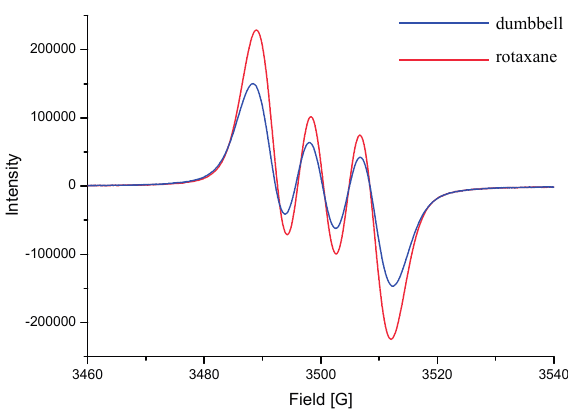
Figure 5. EPR spectra (CH 3 CN, 298 K) of equimolar (3 mM) mixtures of NOBF 4 and the [2]rotaxane 1 (red line) and the dumbbell-shaped molecule 7 (blue line). Dumbbell rotaxane.